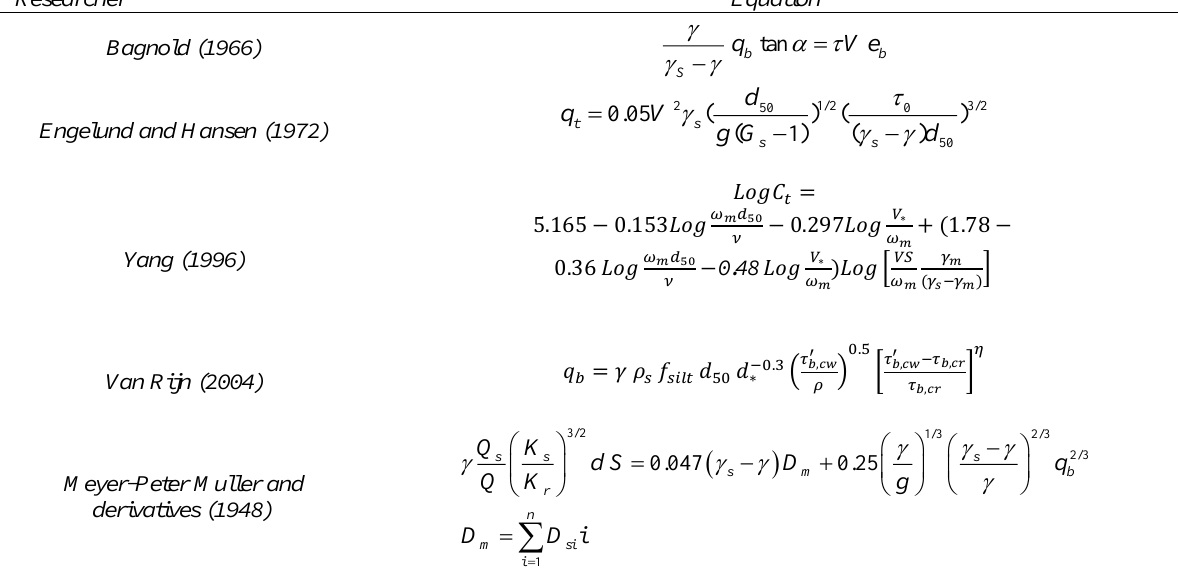
Table 2. Equations which used for calculation of sediment load in Karun River Researcher Equation Bagnold